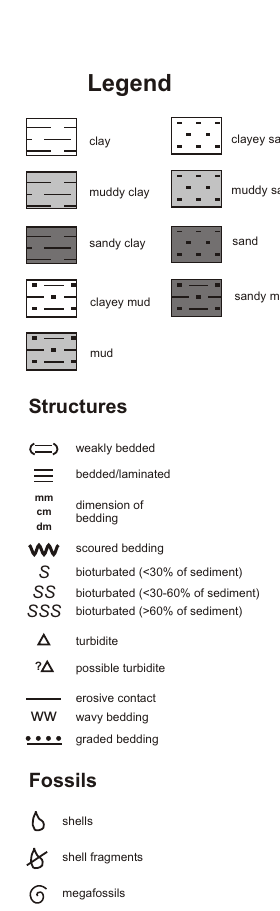
131.5-139 cm: coarse, sand-sized volcanic ash layer., internally layered but not clearly graded 139 -303 cm chaotic structures: large (10 cm) rounded clasts and lenses of silt-fine sand grain size ranging in colour from dark gray to light gray are mixed into a lithological unit: 142-144 cm: dark patch; 150-152 cm: light gray lens; 159 cm: dark gray lens; 161 cm: light gray lens; 163-165 cm: light gray lens next to dark lens; 170 cm: claystone clast 5 mm diameter; 174-176: light patch 182 cm: lens of reworked claystone material 193-194: lens of dark gray fine sand 214-241 cm: silty clay, abundant color changes as layers and mottles 241-244 cm: dark fine sand (ash) layer 244-255 cm: silty clay, abundant color changes 255-260, 271-277, 300-303 cm : dark fine sand (ash) layers layers 340, 354, 357, 378 cm: light gray ash clasts 415.5-423.5 cm: dark gray fine sand layer (ash), distinct lower boundary 443.5, 446.5, 452, 466-468 cm: thin, dark gray layers in homogeneous gray silty clay matrix 470.5-495 cm: wavy layering, lenses of different colors defined by inclined lithological boundaries, slightly chaotic. 497-516 cm: homogeneous silty clay 513.5 cm: thin, dark gray layer in homogeneous gray silty clay matrix